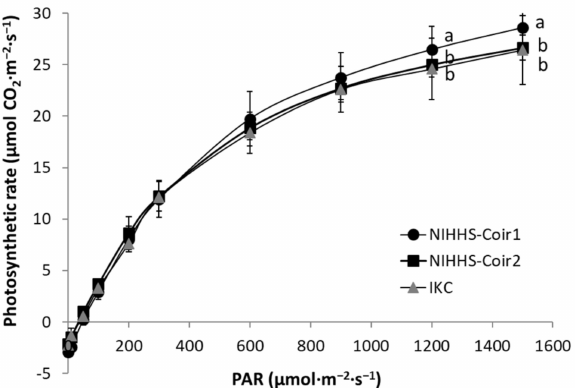
Figure 9. Light-response curves of net photosynthesis in the fully expanded leaves of paprika ‘Cupra’ at the late stage of cultivation (eight months after transplant) as affected by different nutrient solution compositions in the closed hydroponic system with a coir substrate. DMRT at p ≤ 0.05 and different lowercase letters indicate significant differences between treatments. Vertical bars indicate standard errors of the means ( n = 5). Table 4. Marketable yield characteristics of paprika ‘Cupra’ affected by the compositions of the nutrient solutions in Experiment 2, NIHHS-Coir1, NIHHS-Coir2, and IKC, according to growth stages during the winter cropping season in a closed hydroponic system with a coir substrate. Fruit Weight No. of Fruits/Plant Marketable Yield Marketable (kg)/Plant ( n = (kg/m 2 ) Fruit Ratio (%) ( n = 30)